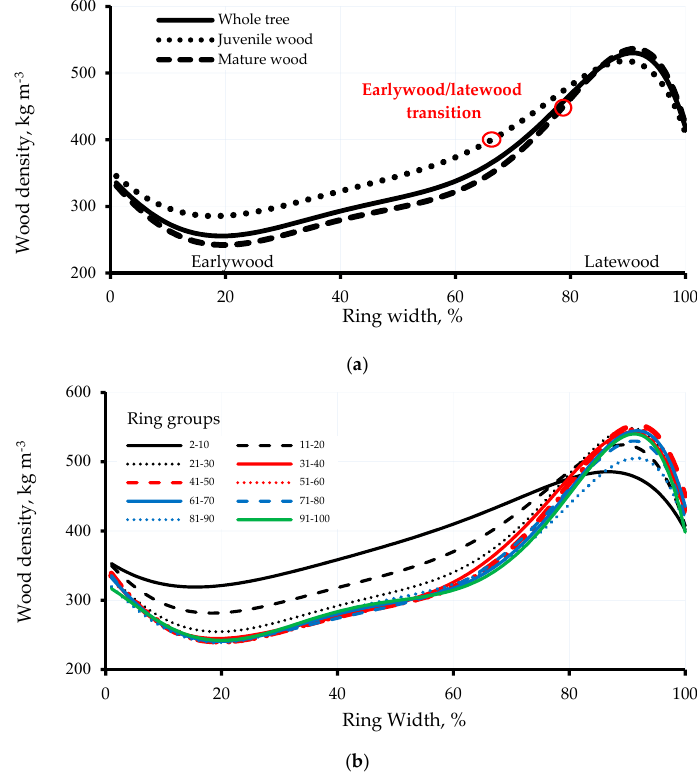
Figure 1. Intra-ring wood density profiles of: ( a ) the whole tree (rings 2–100 rings), the juvenile (rings 2–30) and mature wood (rings 31–100) and ( b ) selected ring groups in 44 T. occidentalis